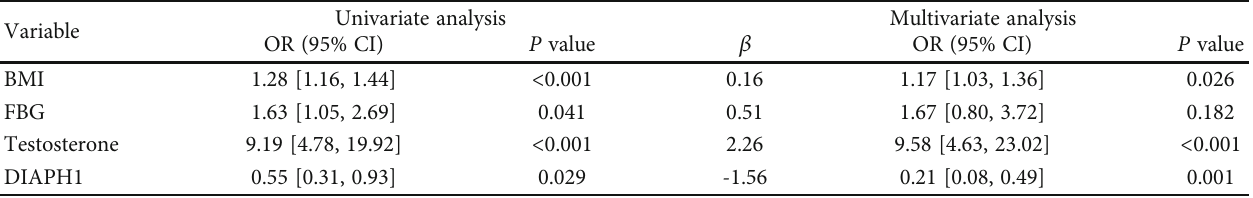
OR: odd ratio; CI: con fi dence interval; β is the regression coe ffi